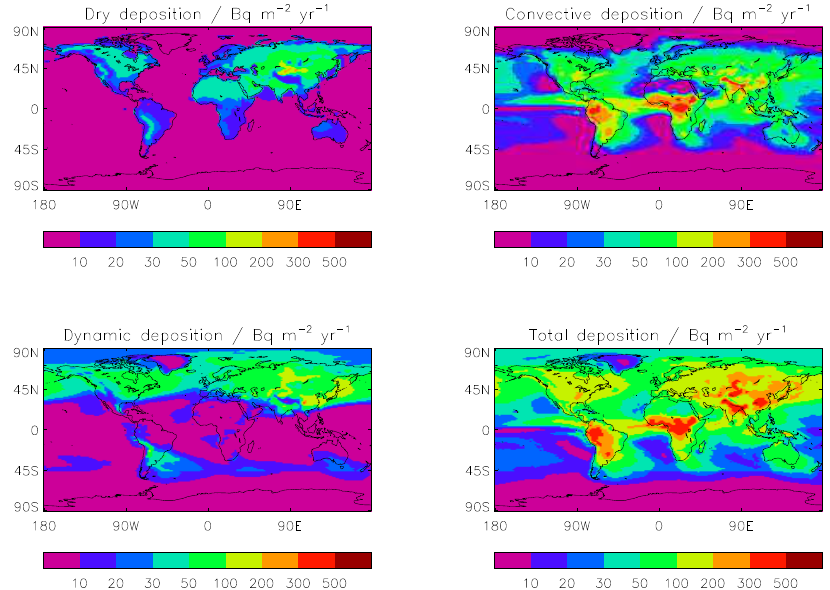
Fig. 8. Global multi-annual mean distribution of 210 Pb deposition fluxes from UKCA: Dry deposition, convective scavenging, dynamic scavenging, and total deposition flux. Units are in Bqm − 2 yr − 1 .